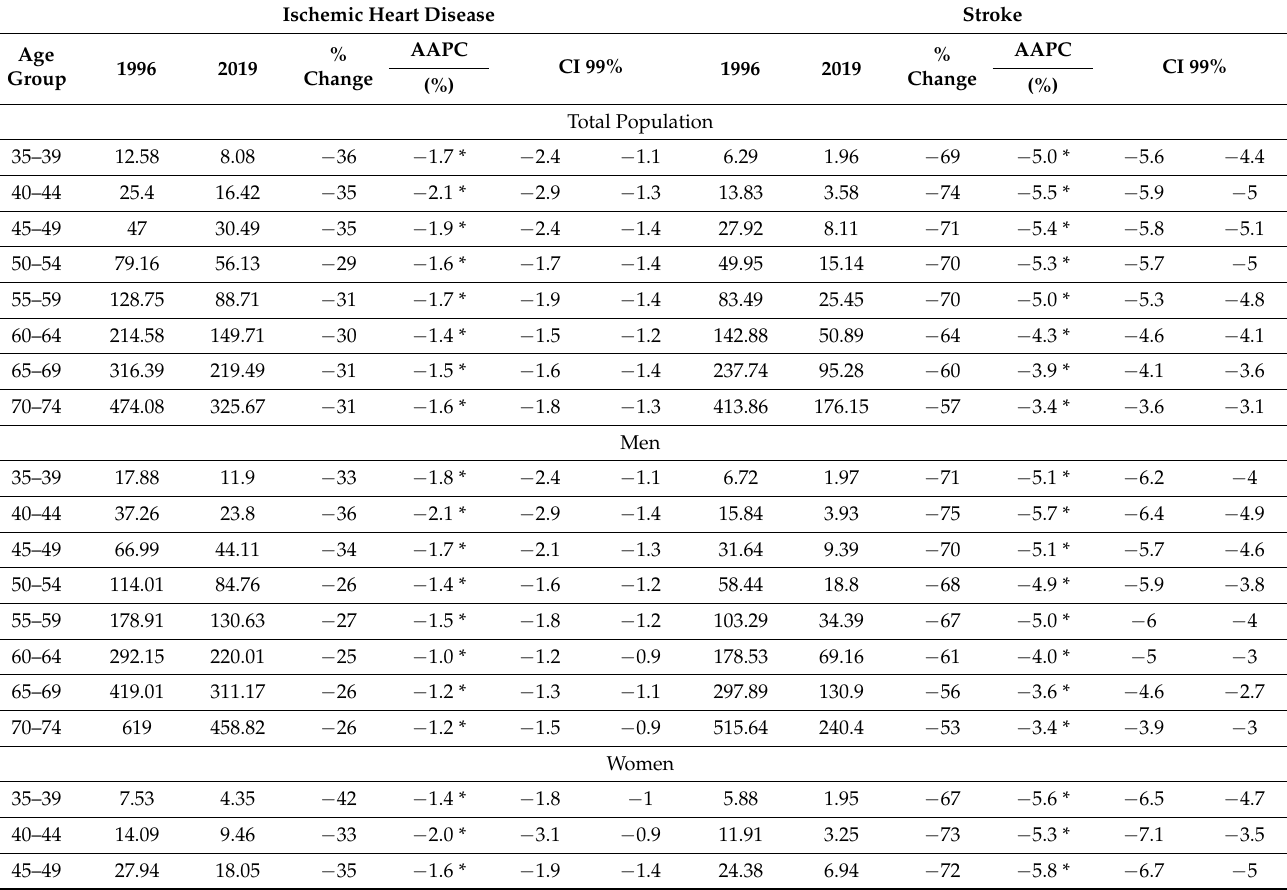
Table 4. The crude death rate, the percentage change between 1996 and 2019, mean annual per- centage change (AAPC), and 99% confidence limits (99%CL) due to ischemic heart diseases and cerebrovascular diseases per 100,000